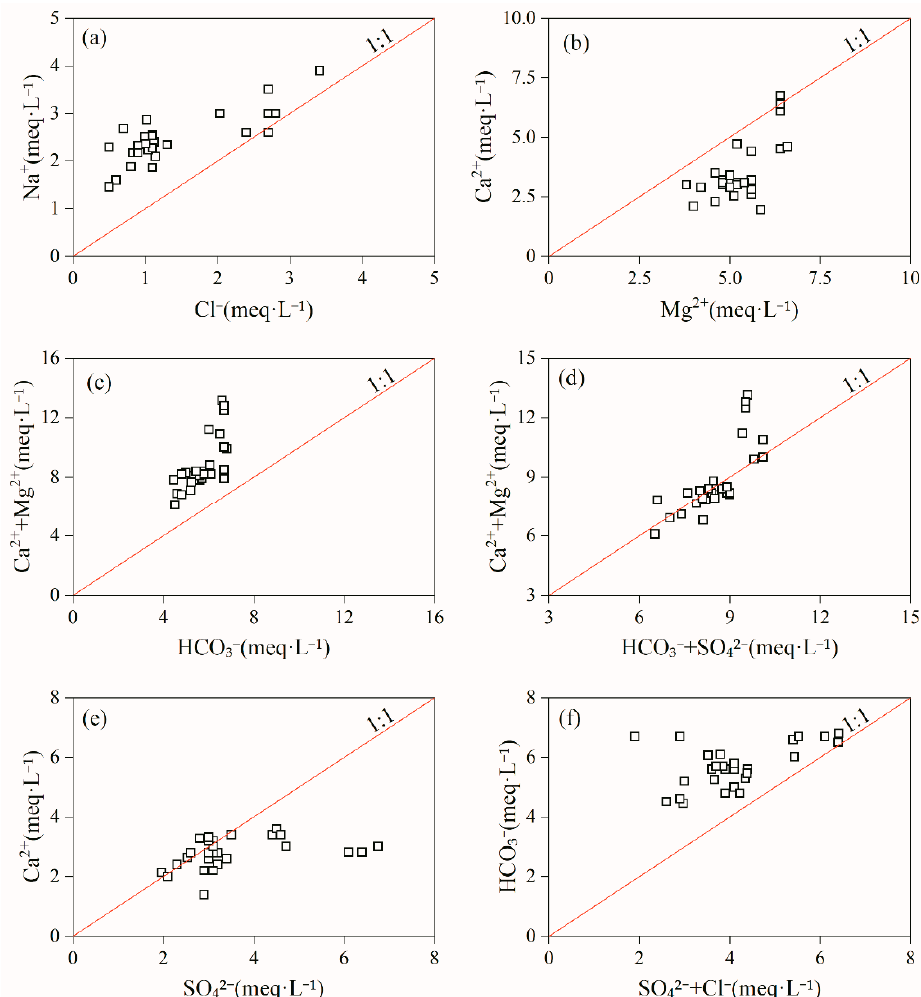
Figure 7. Relationship between the main ion ratios of Srrich groundwater. ( a ) Cl − and Na + ; ( b ) Mg 2+ and Ca 2+ ; ( c ) HCO 3 − and (Ca 2+ + Mg 2+ ); ( d ) (HCO 3 − + SO 42 − ) and (Ca 2+ + Mg 2+ ); ( e ) SO 42 − and Ca 2+ ; ( f ) (SO 42 − + Cl − ) and HCO 3 −